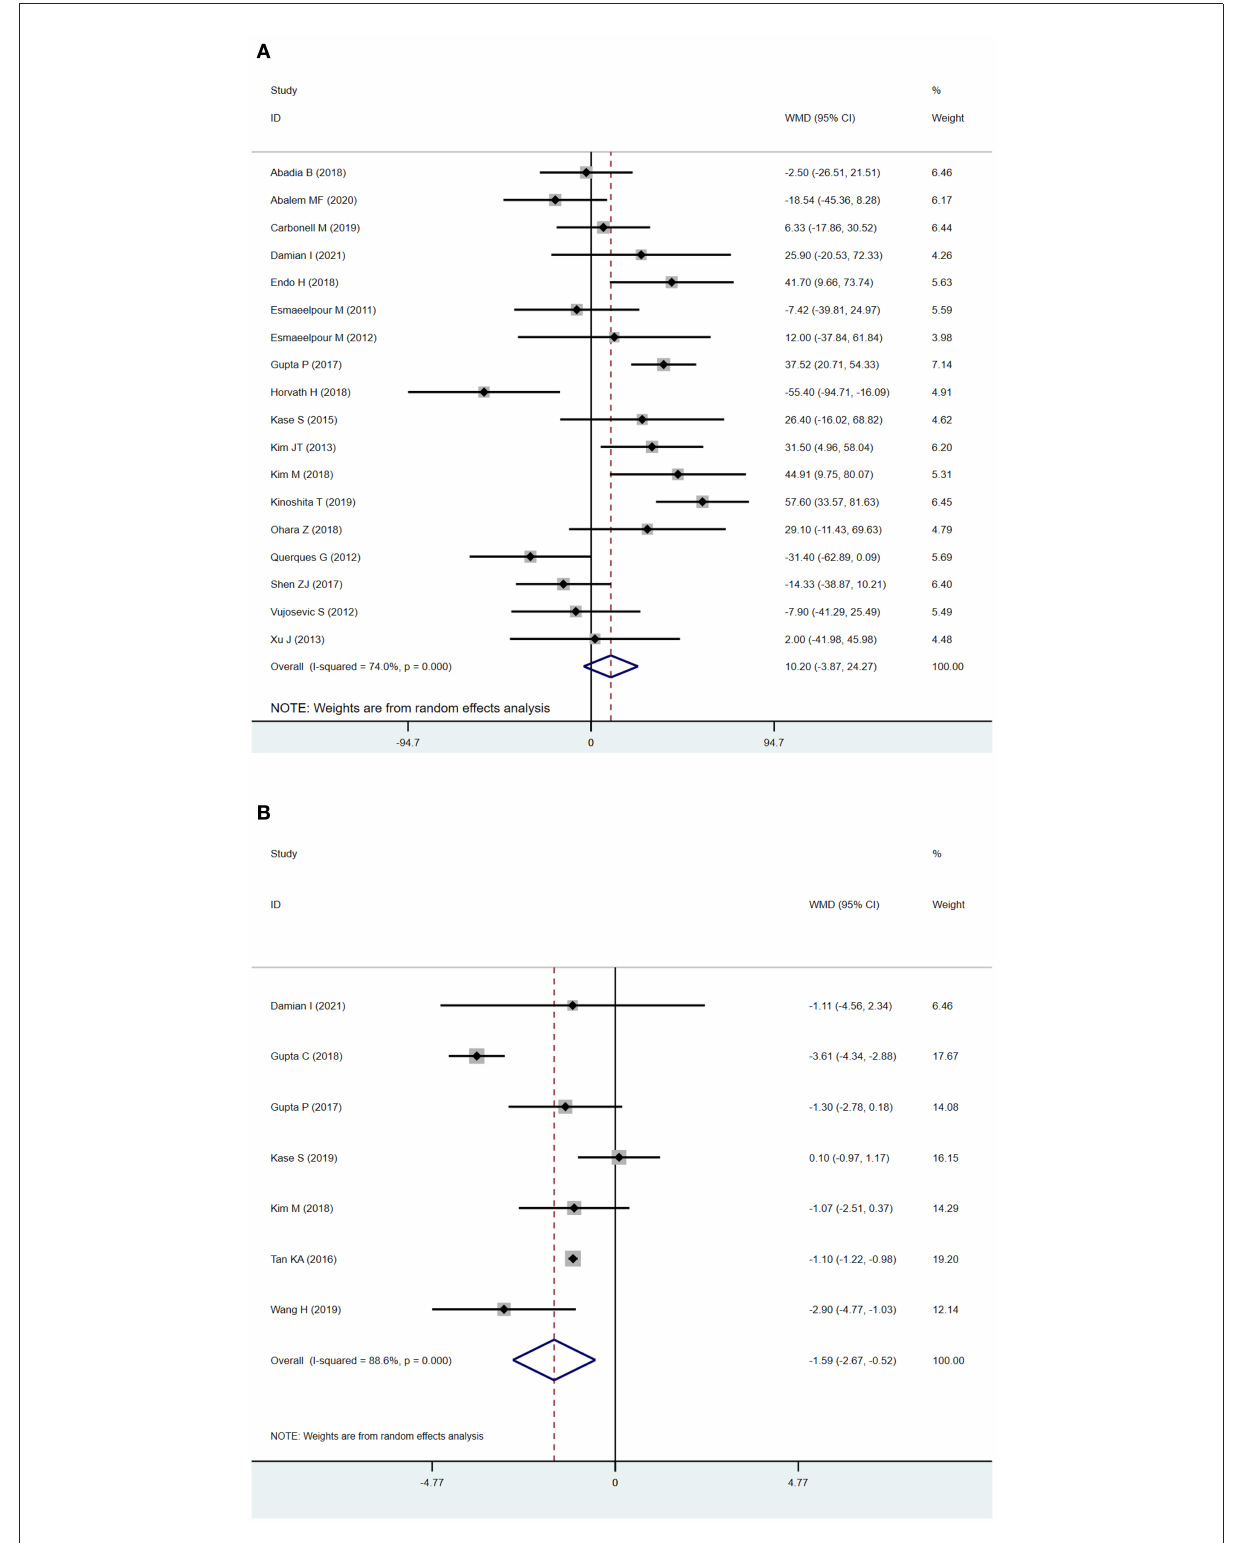
FIGURE2 Subfoveal choroidal thickness (SFCT) and choroidal vascularity index (CVI) in patients with NDR and DR. (A) SFCT. (B)